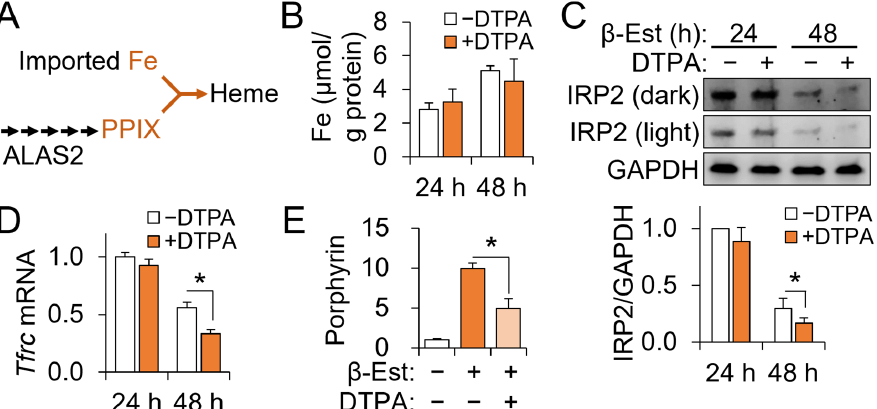
Figure 3. Cellular zinc restriction impairs porphyrin production by developing G1E-ER4 cells without changing cellular iron contents. ( A ) Simple scheme of the heme biosynthetic pathway. ( B ) Lack of changes in cellular iron contents of developing G1E-ER4 cells by DTPA. Cellular contents were normalized to total protein ( n = 4). ( C ) IRP2 protein abundance in response to differentiation induction and DTPA treatments in G1E-ER4 cells ( n = 3). Dark and light indicate images captured at higher and lower intensity, respectively. ( D ) Changes in Trfc mRNA abundance, a regulatory target of IRP2, by differentiation and DTPA ( n = 3). ( E ) Reduction in total porphyrin contents by DTPA in differentiating G1E-ER4 cells. Total porphyrin contents were determined after 48 h of treatments and normalized to cell numbers. Data presented as mean ± SD. * p < 0.05. β -Est, β -estradiol;